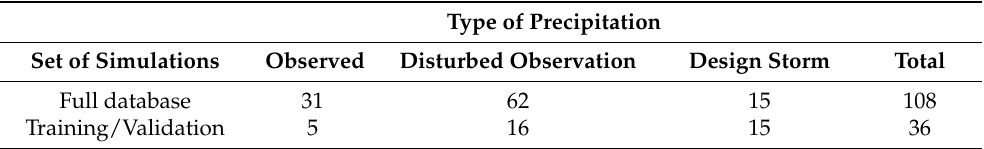
Figure 4. Timeseries of the AID of the simulated rainfall events in ( a ) the entire database and ( b ) in the selection using the CADEX algorithm. Table 2. Number of events in each set of